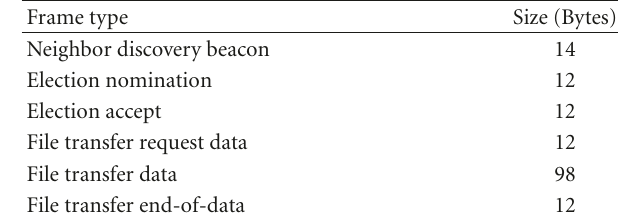
Table 1: CARNIVORE frame types and size (including 802.15.4 header and footer).